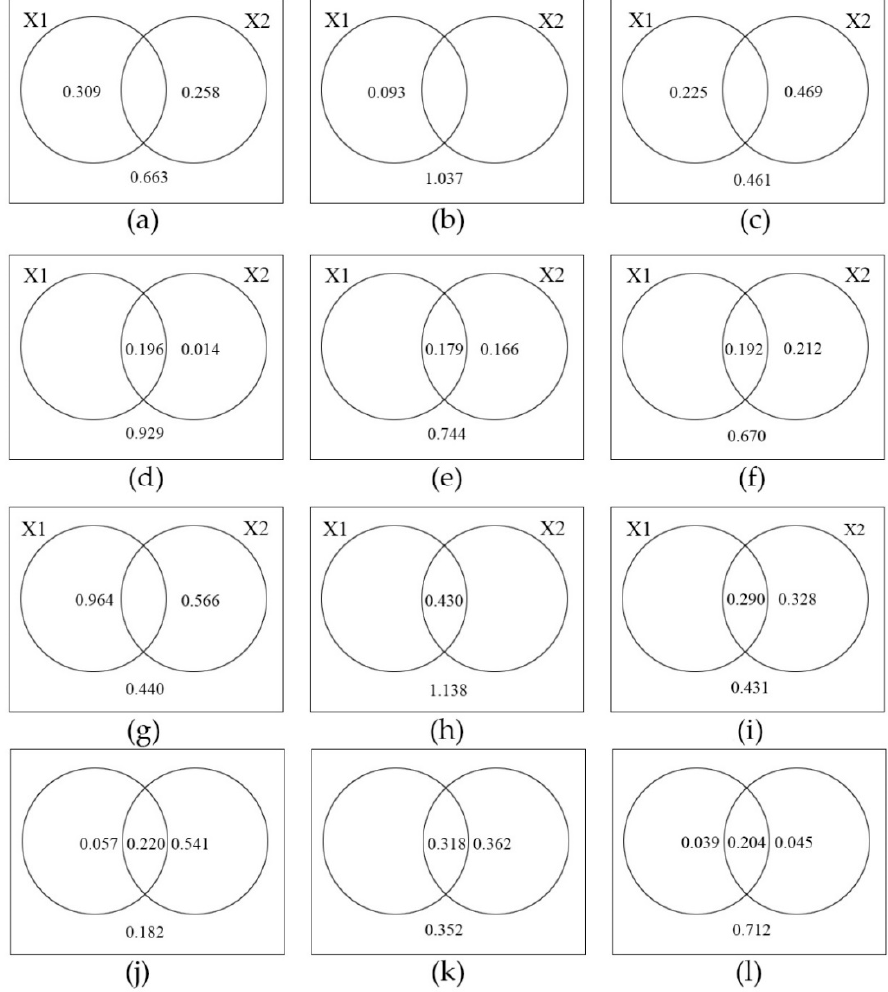
Figure 5. Percentage contributions of explanatory variables to the variation of PM 2.5 and PM 10 (X1 represents composition metrics of greenspace, and X2 represents configuration metrics of greenspace. From ( a – f ), showing the Venn diagram from scale 1 km × 1 km to scale 6 km × 6 km for PM 2.5 ; from ( g – l ), showing the Venn diagram from scale 1 km × 1 km to scale 6 km × 6 km for PM 10 ).